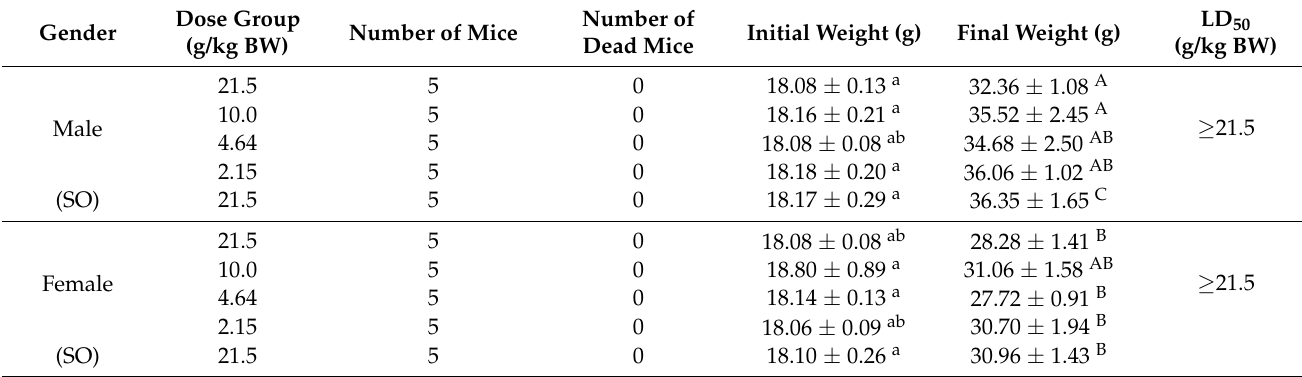
Table 4. The acute oral toxic effects of CCSKO in SPF ICR